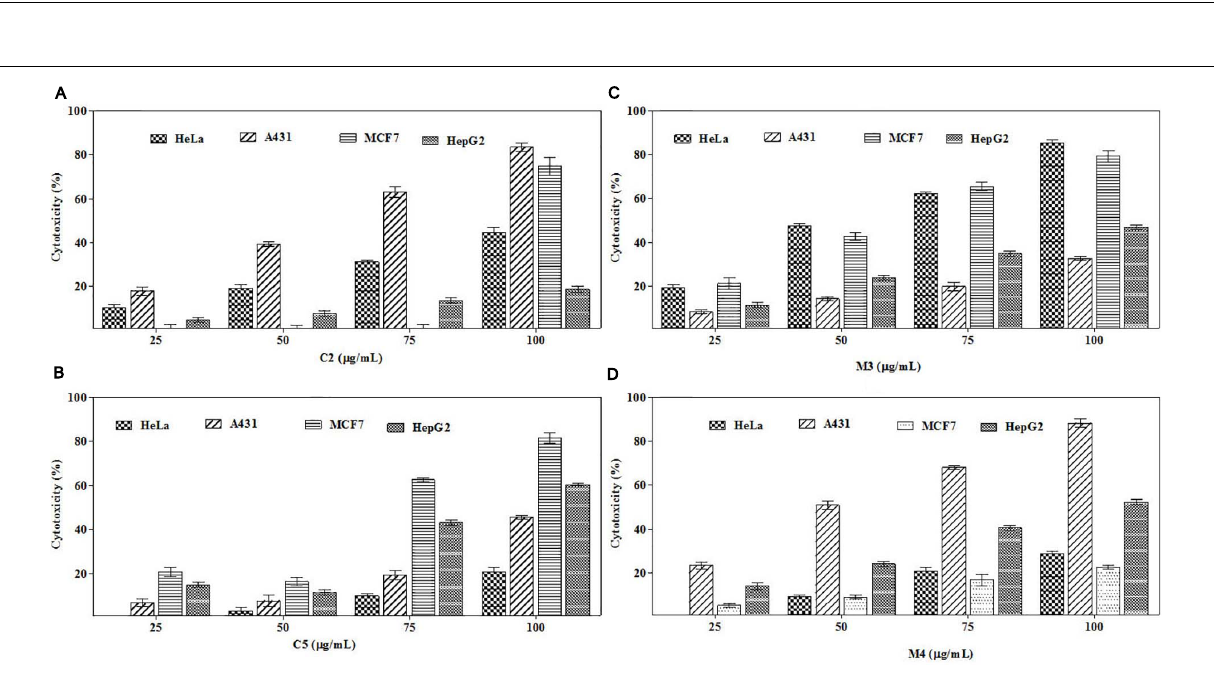
Frontiers in Microbiology |